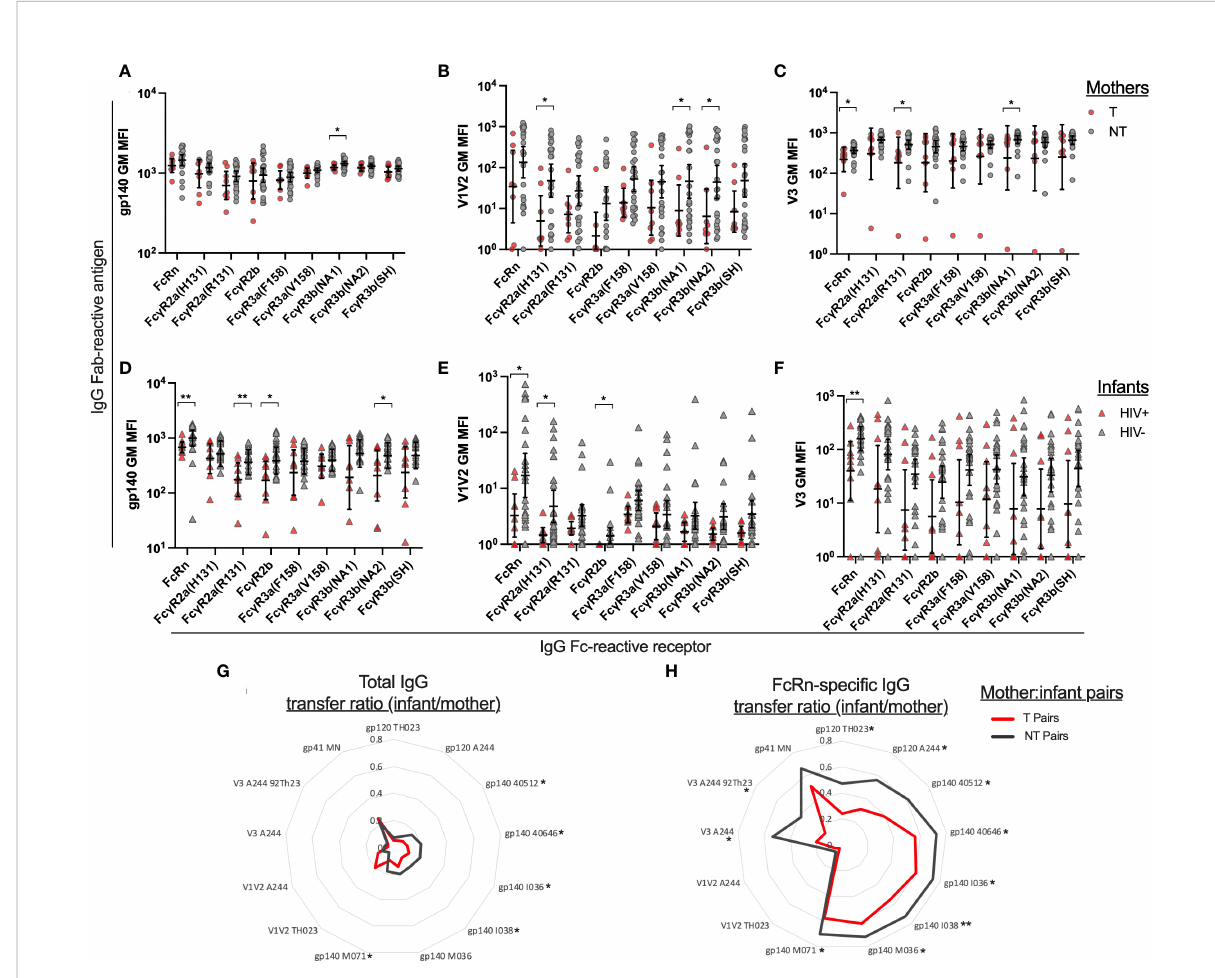
FIGURE 3 Plasma IgG Fc receptor binding and transfer ef fi ciency of Env-speci fi c plasma IgG from mothers to infants. Using Luminex multiplex assays, plasma antibodies were evaluated for HIV Env antigen binding and Fc receptor engagement. The geometric mean of the mean fl orescence intensity (MFI) was determined for six gp140 proteins, two V1V2 proteins, and two V3 antigens. Fc Receptor (FcR) engagement is shown for transmitting (T) and non-transmitting (NT) mother plasma antibodies binding to HIV antigens (A) gp140 (B) V1V2 and (C) V3. Fc Receptor (FcR) engagement is shown for HIV+ and uninfected (HIV-) infant plasma antibodies binding to HIV antigens (D) gp140 (E) V1V2 and (F) V3. Binding antibody transfer ratios were calculated by dividing the infant MFI for a speci fi c antigen/FcR combination by the matched mother MFI for the same antigen/FcR combination. The geometric mean of the transfer ratio is shown in radar plots for the transmitting mother-infant pairs (red line) and non-transmitting mother-infant pairs (gray line) for individual antigens for (G) total IgG and (H) FcRn-speci fi c IgG. Signi fi cant differences were determined by Mann-Whitney test and are indicated by * above the plots; * = p < 0.05, ** = p <